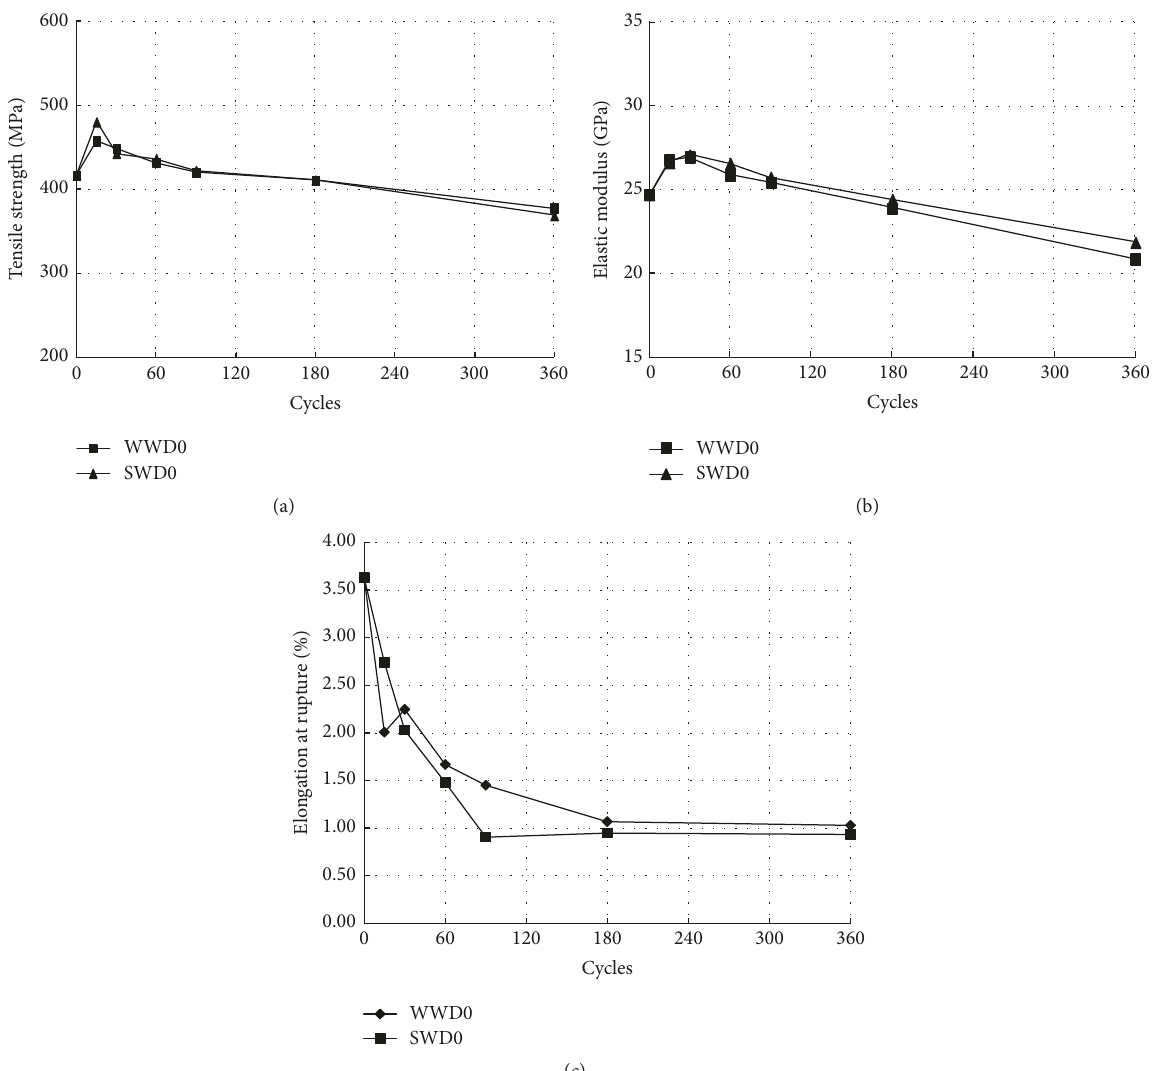
Figure 3: Mechanical properties of unstressed specimens exposed to WD cycles: (a) tensile strength; (b) elastic modulus; (c) elongation at rupture. Note. WWD0 is unstressed specimen exposed to WD cycles of distilled water; and SWD0 is unstressed specimen exposed to WD cycles of